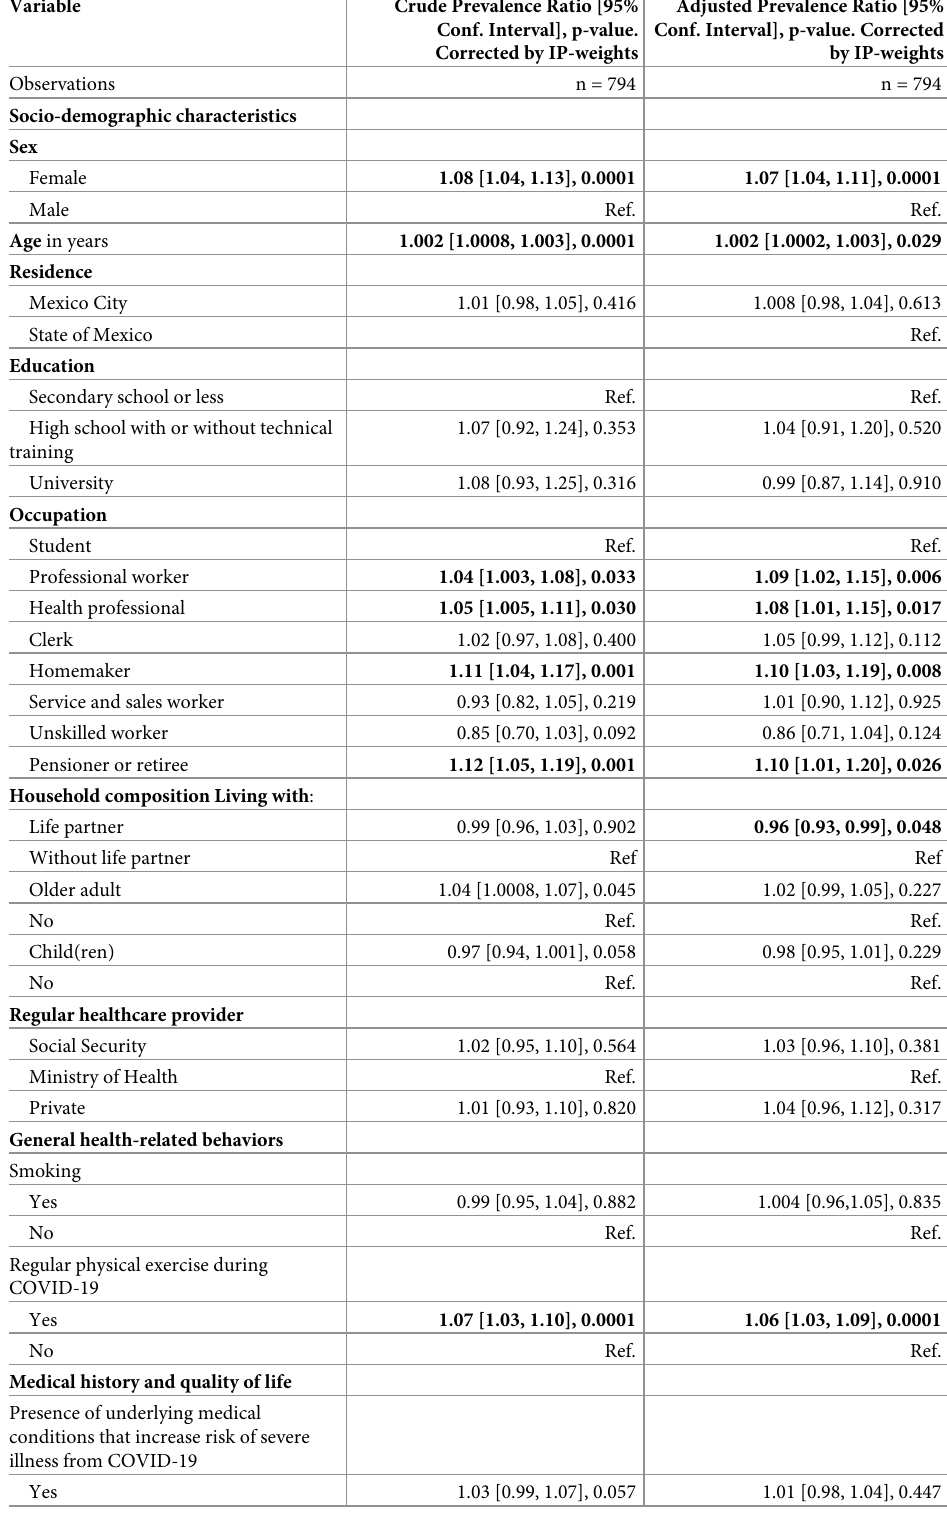
Table 4. Factors associated with the use of COVID-19 preventive